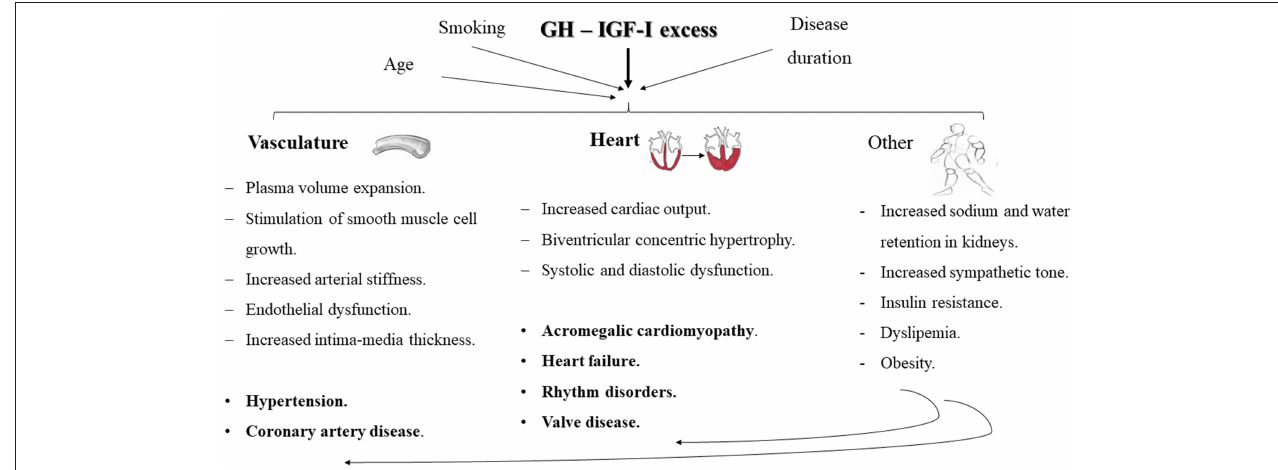
FIGURE 1 | Schematic representation of the main cardiovascular comorbidities encountered in patients with acromegaly and the key mechanisms involved in their development. Chronic GH hypersecretion and/or IGF-I excess, exacerbated by the influence of other concomitant issues, such as disease duration, age and smoking, may lead to plasma volume expansion, stimulation of smooth muscle cell growth, increased arterial stiffness and endothelial dysfunction and increased intima-media thickness, which may all contribute to the development of hypertension and coronary artery disease. Besides, an increased vascular responsiveness to angiotensin II, sodium and water retention, and an increase in cardiac output, may also contribute to an increased peripheral resistance and exacerbate the development of hypertension. Increased cardiac output, biventricular concentric hypertrophy and systolic and diastolic dysfunction configure the key milestones in the development of acromegalic cardiomyopathy, eventually leading to heart failure. Other typical cardiac alterations in acromegalic patients include rhythm disorders and valve disease. Furthermore, there have been studies suggesting a role of the sympathetic tone in the development of comorbidities in acromegaly. Insulin resistance, obesity and an atherogenic lipid profile may aggravate the progression of cardiovascular